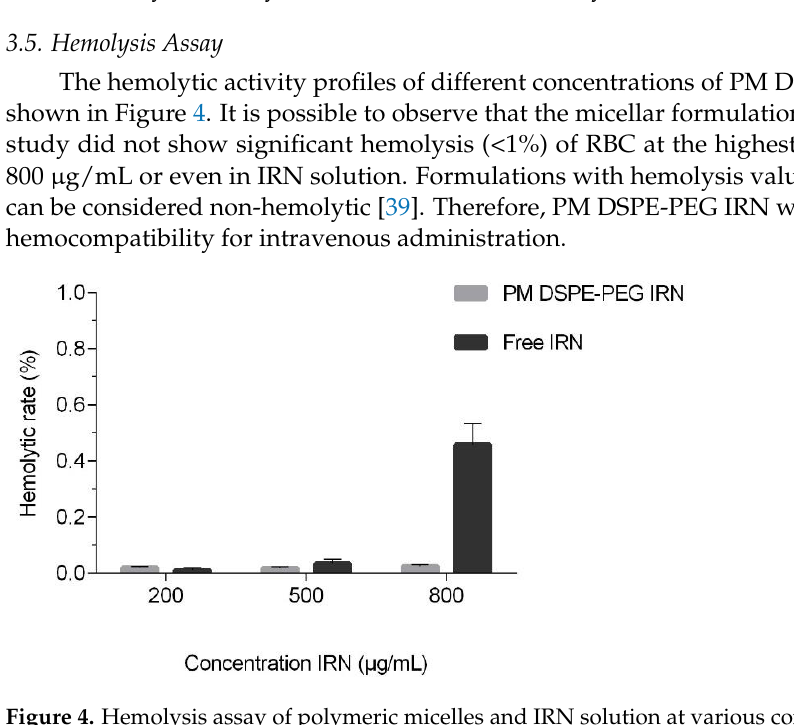
Figure 4. Hemolysis assay of polymeric micelles and IRN solution at various concentrations.